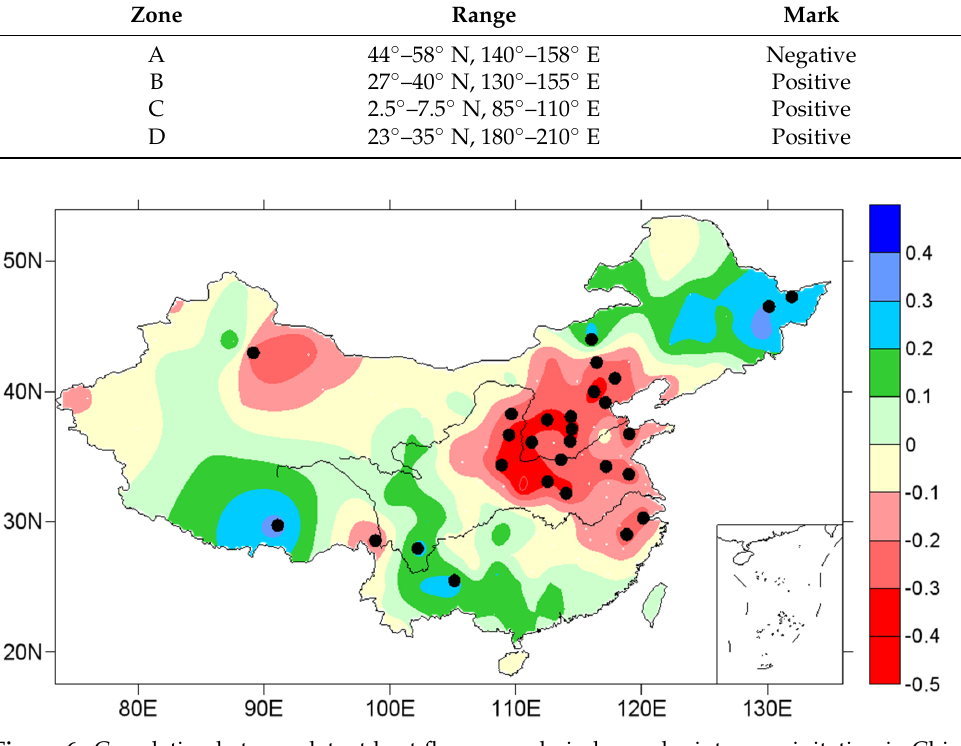
Figure 6. Correlation between latent heat flux anomaly index and winter precipitation in China. Stippling indicates stations that passed the 0.05 significance test. (Units: latitude is °N, and longitude is °E).